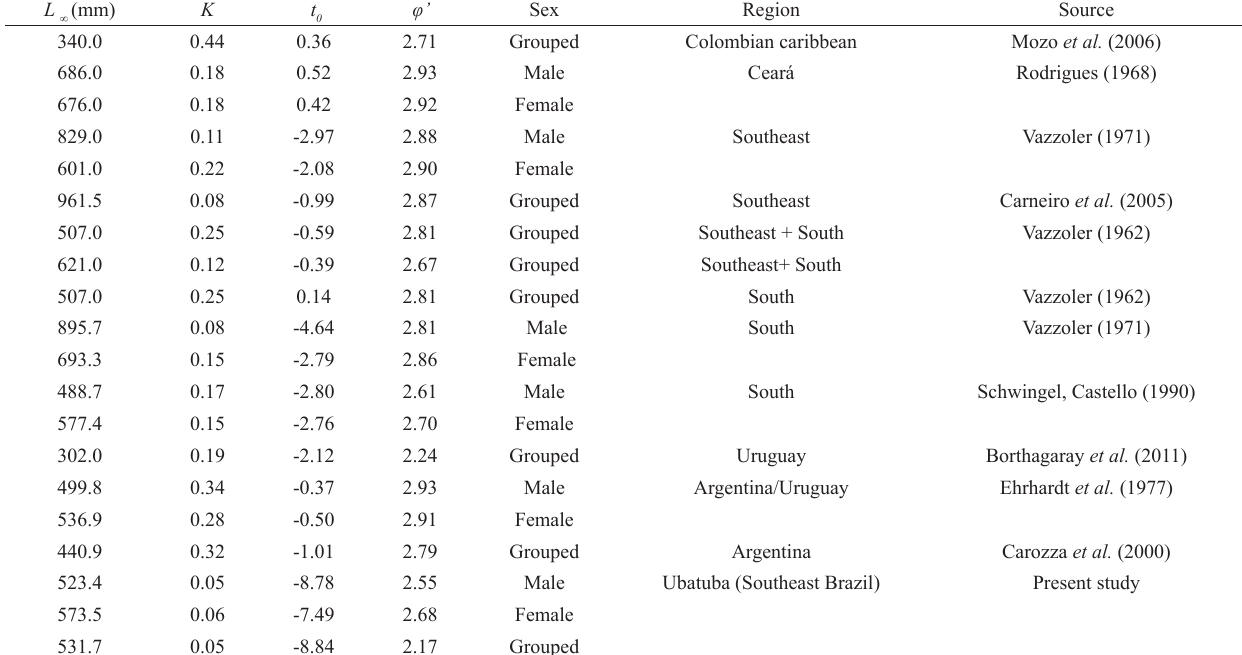
Tab. 2. Growth parameters for Micropogonias furnieri along its distribution area. L ∞